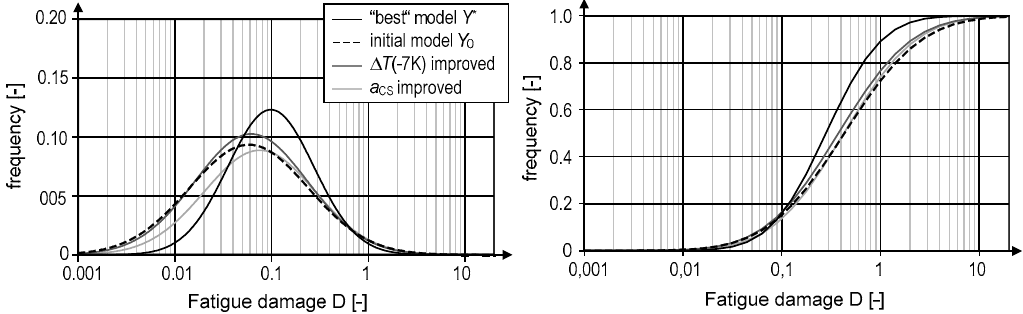
Figure 8. Probability and cumulative density functions of the original ( Y 0 ) and the best model ( Y *) along with two cases when only one parameter’s scatter is reduced by monitoring.